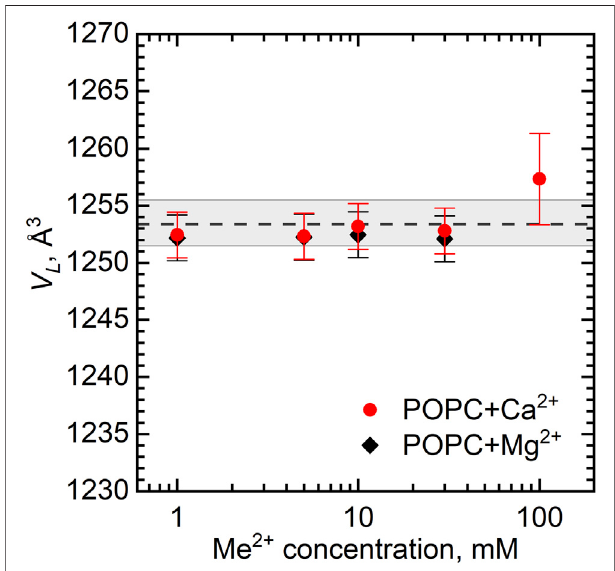
FIGURE 2 | Dependence of volume per lipid V L on the concentration of Ca 2+ andMg 2+ inPOPCvesiclesat T =25 ° C.Thedashedlinerepresents V L of neat POPC MLVs with the wide gray band depicting its standard deviation.